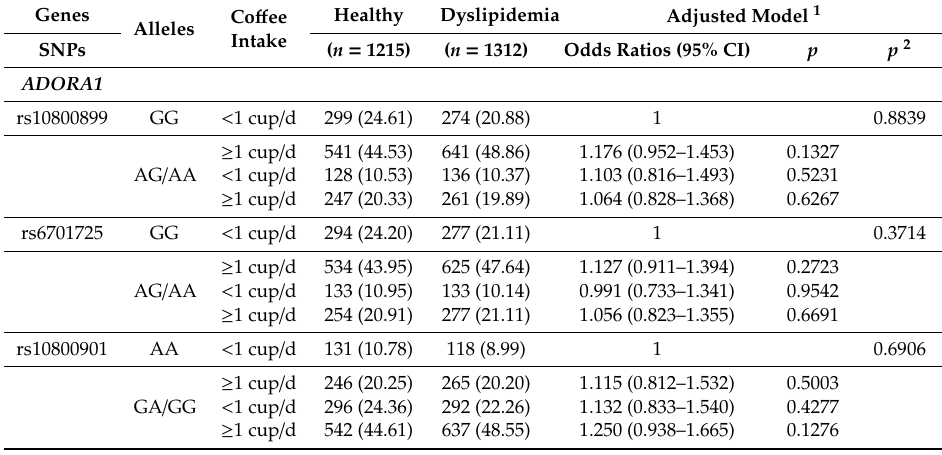
Table 4. Risk of dyslipidemia depending on the co ff ee intake and genotype in ADORA gene family in